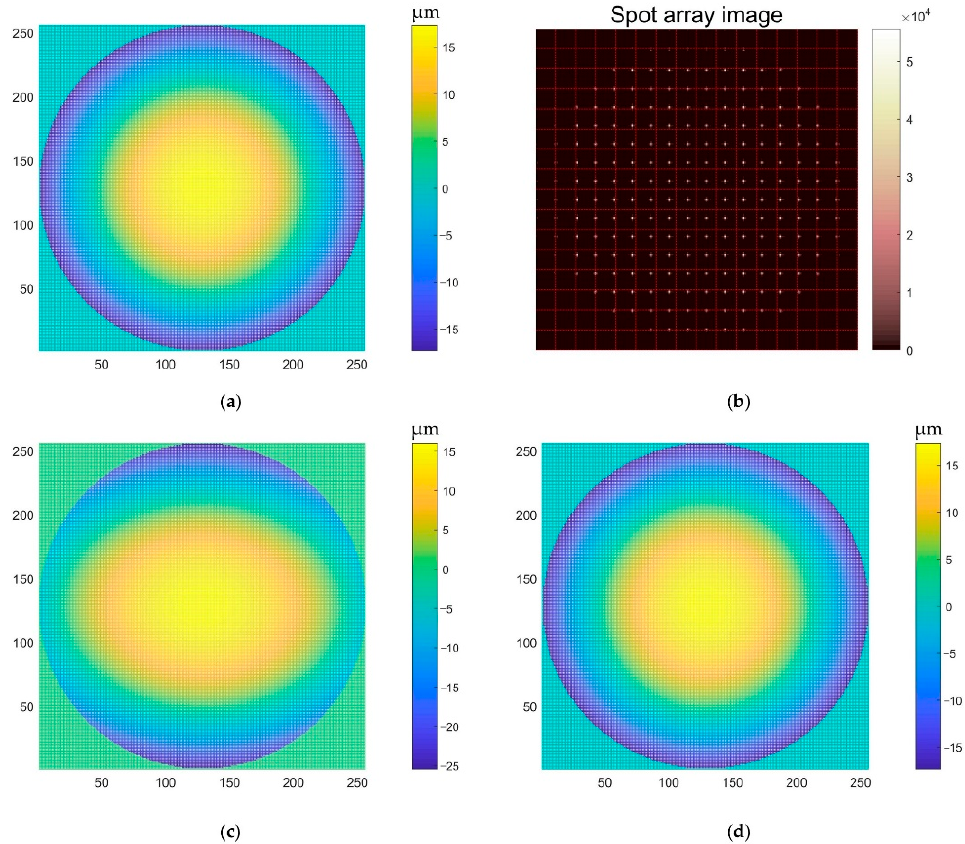
Figure 7. Z 0 ( a ) Reference wavefront; ( b ) spot array; ( c ) wavefront reconstructed with the classical 2 algorithm; ( d ) wavefront reconstructed with our algorithm.